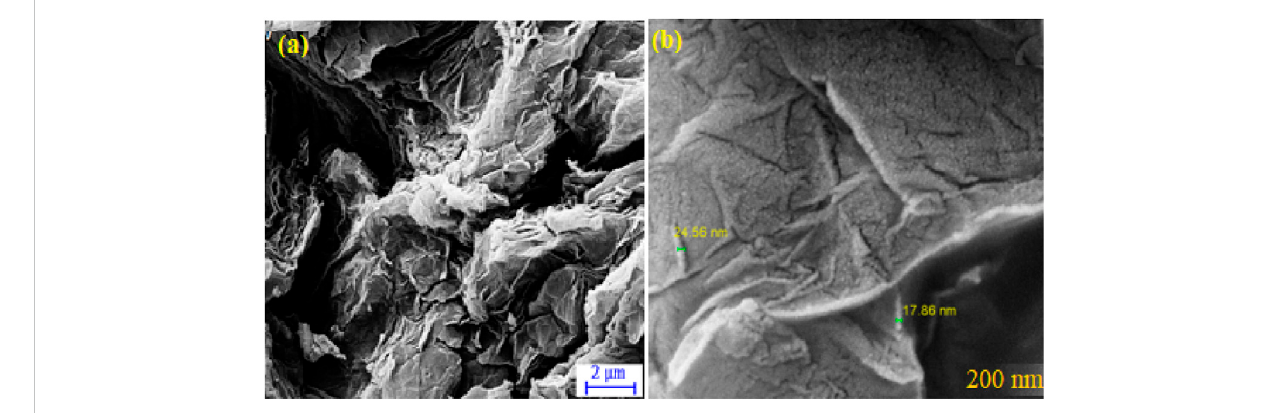
FIGURE 2 FE-SEM image of (A) GO and (B) Cu-PTC@GO.